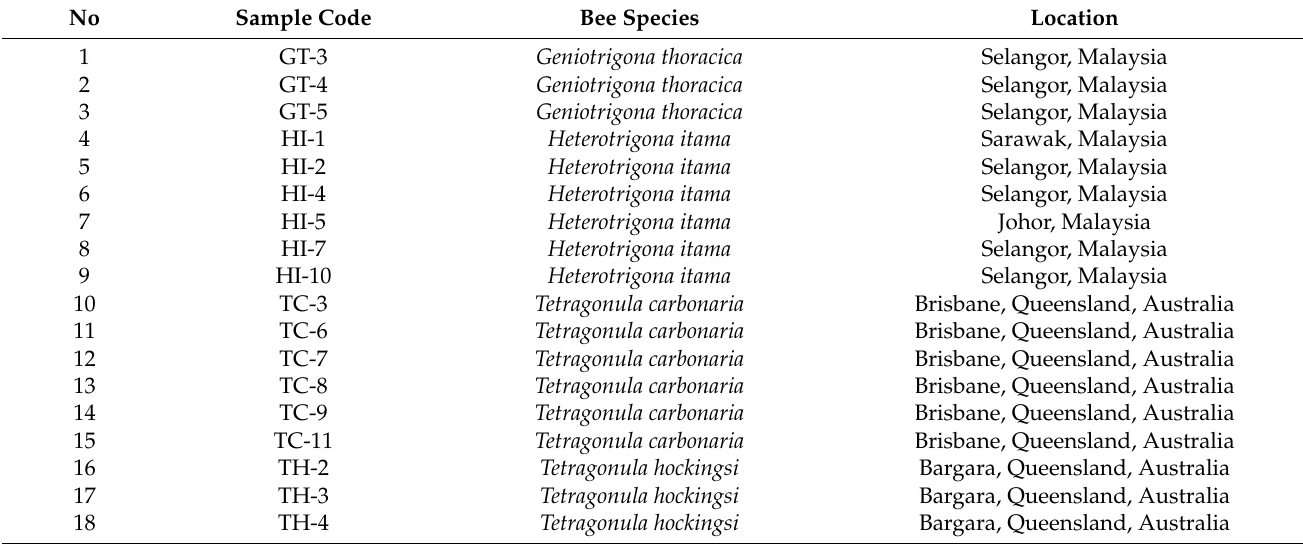
Figure 5. Minimum inhibitory concentration (MIC) of SBH from Malaysian and Australian against a few bacteria: ( a ) Pseudomonas aeruginosa , ( b ) Escherichia coli , ( c ) Klebsiella pneumoniae , ( d ) Salmonella typhimurium , ( e ) Bacillus cereus , and ( f ) Staphylococcus aureus . Different superscripts, a–c, indicate significant differences ( p < 0.05) between the temperatures, and the different superscripts A–D indicate significant differences ( p < 0.05) between the stingless bee honeys. Table 2. Stingless bee honey samples and their geographical